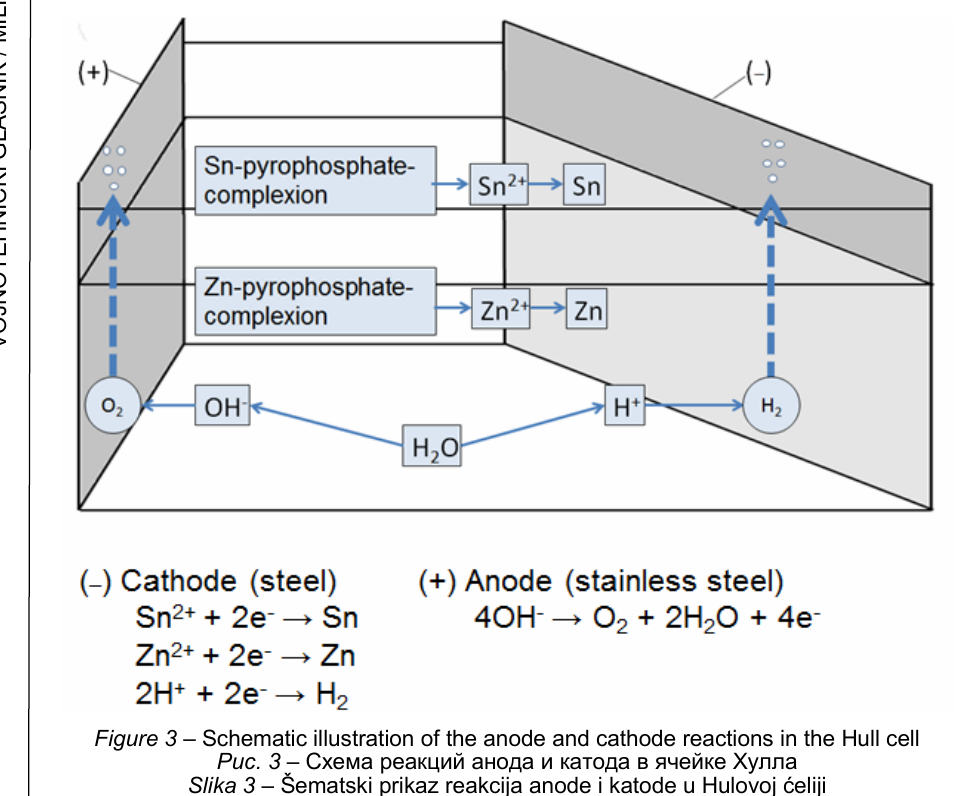
Figure 3 – Schematic illustration of the anode and cathode reactions in the Hull cell Рис . 3 – Схема реакций анода и катода в ячейке